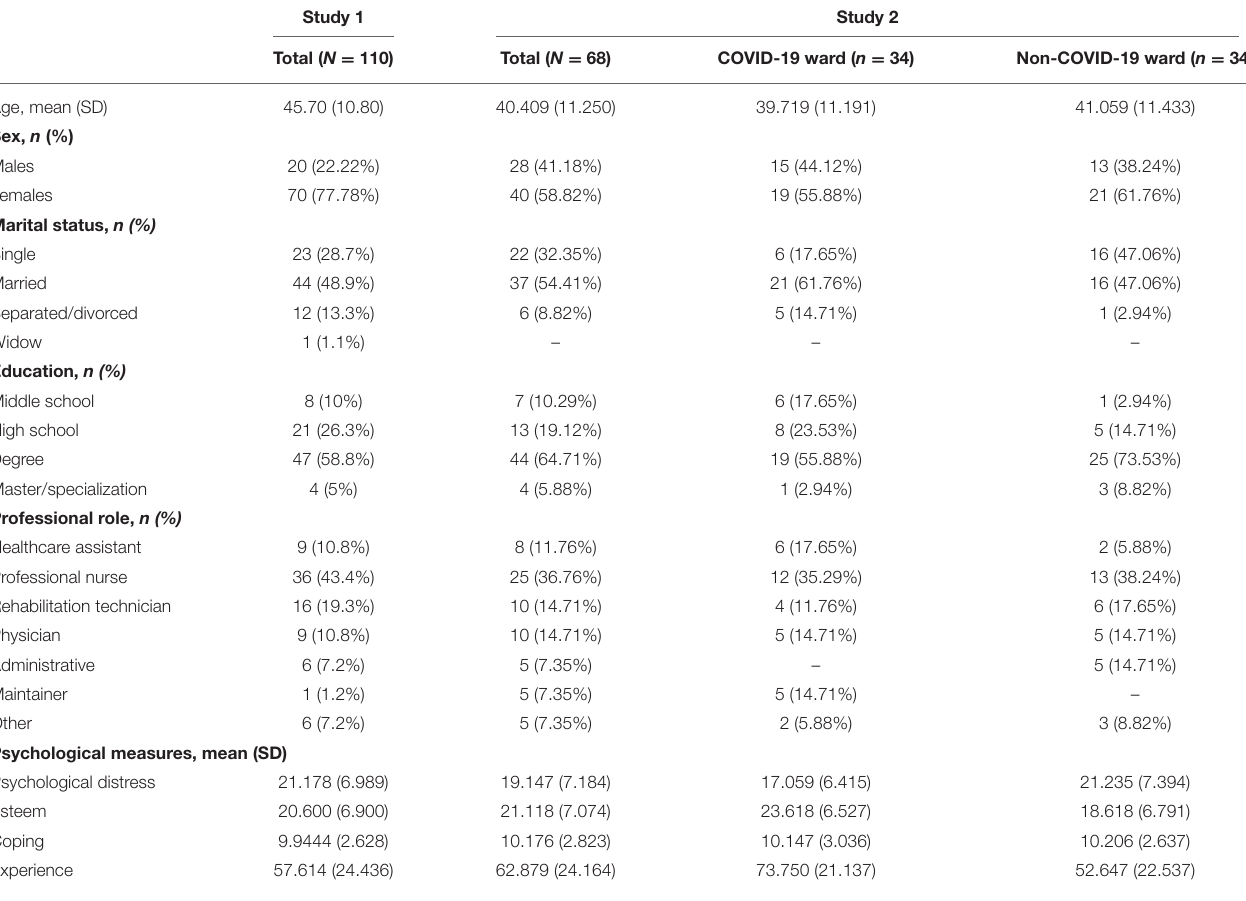
TABLE 1 | Study 1 and Study 2: descriptive statistics of the